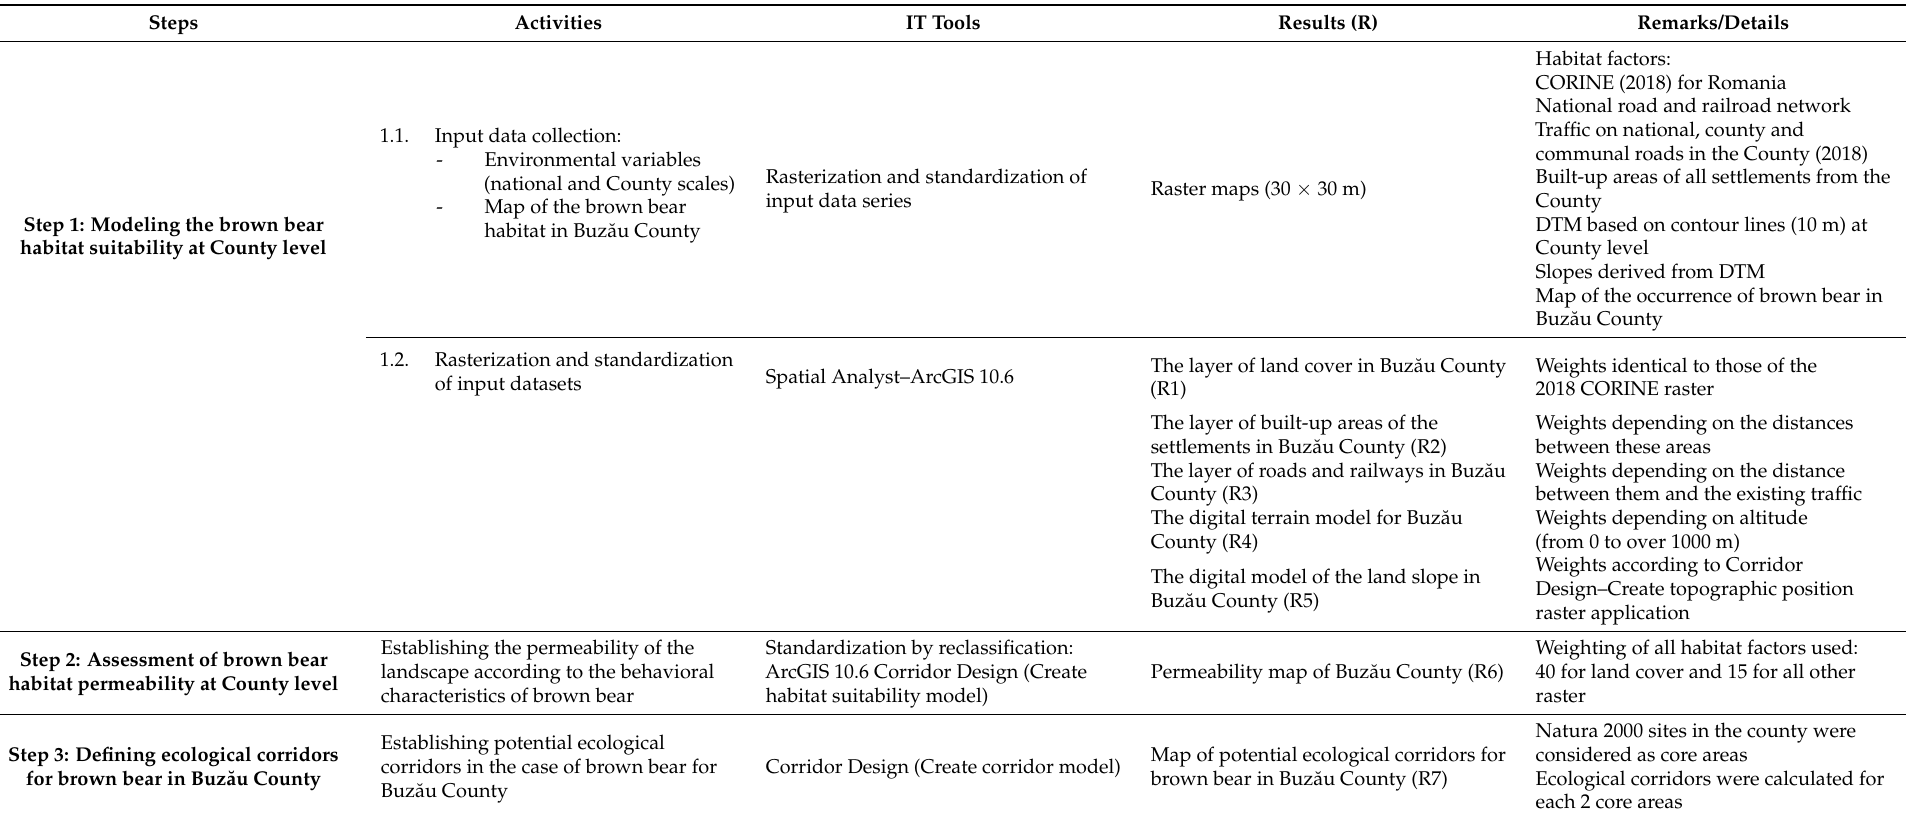
Table 5. Methodology: Steps to identify ecological corridors for the brown bear at county level. Each step is described in terms of sub-steps, activities, software and results. Habitat factors used as input data, chosen weights, intermediate and final results are also described. At this scale more attention was given to details of